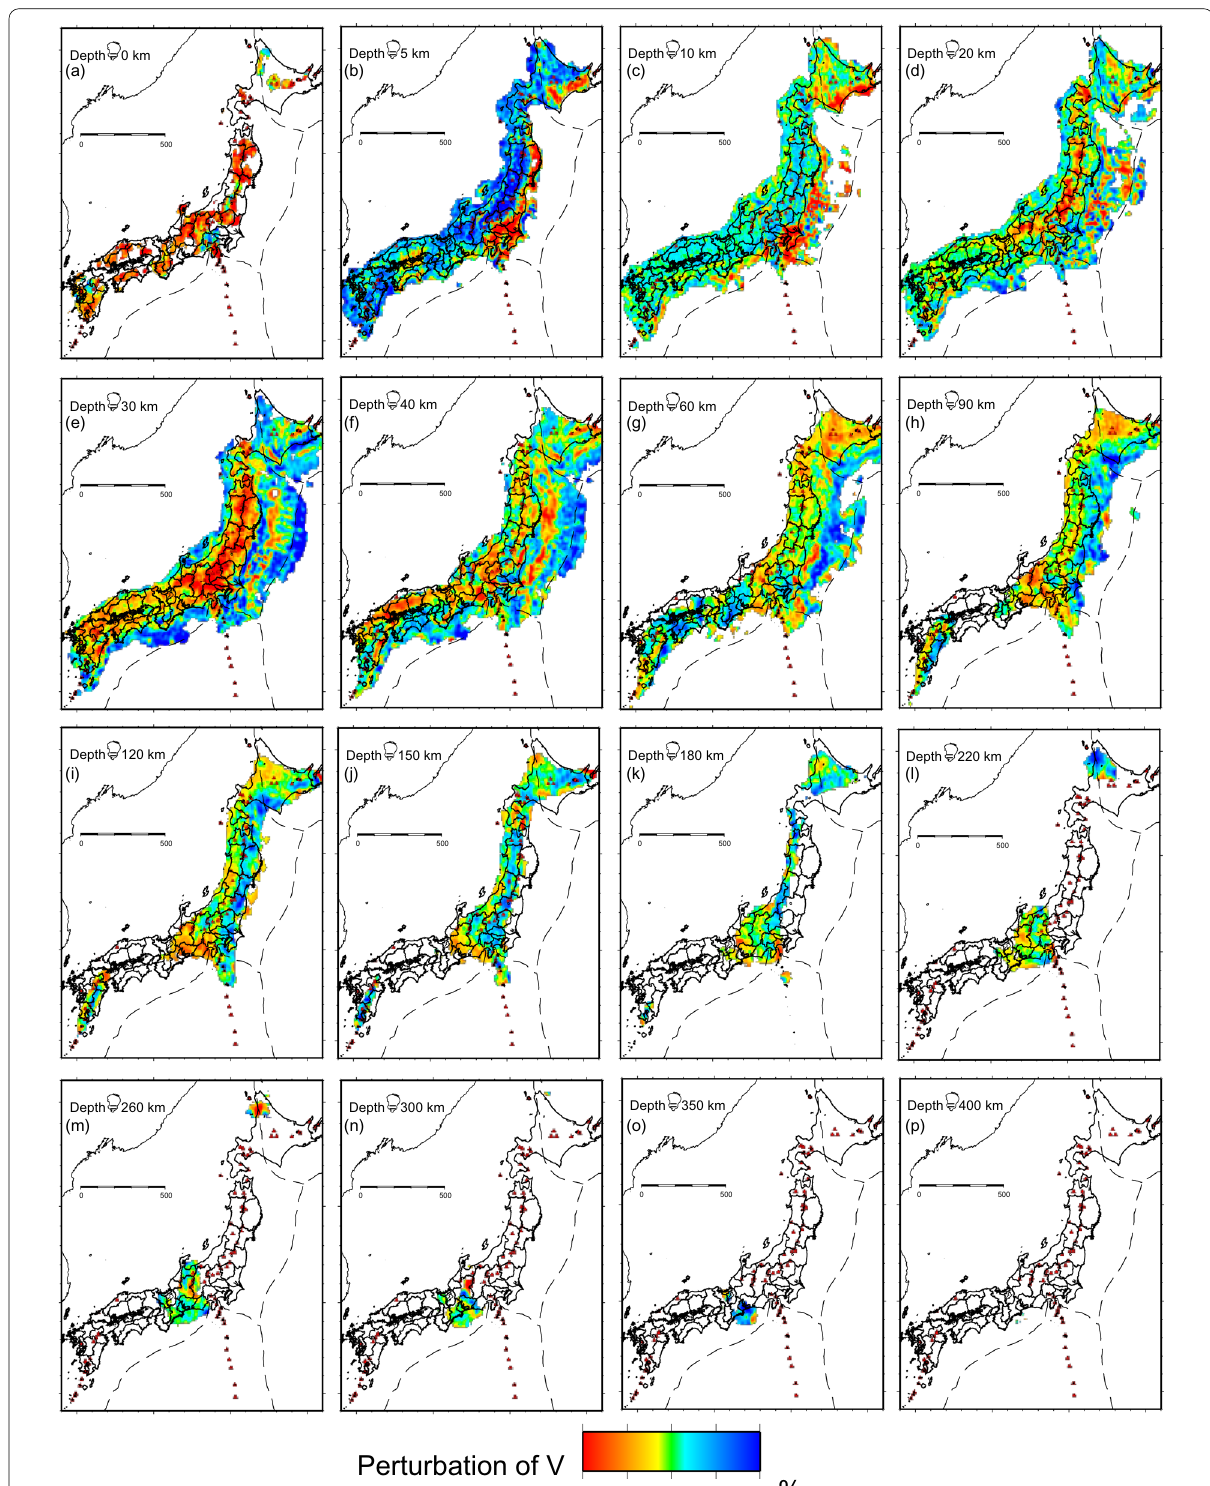
Fig. 14 Results of restored resolution test for